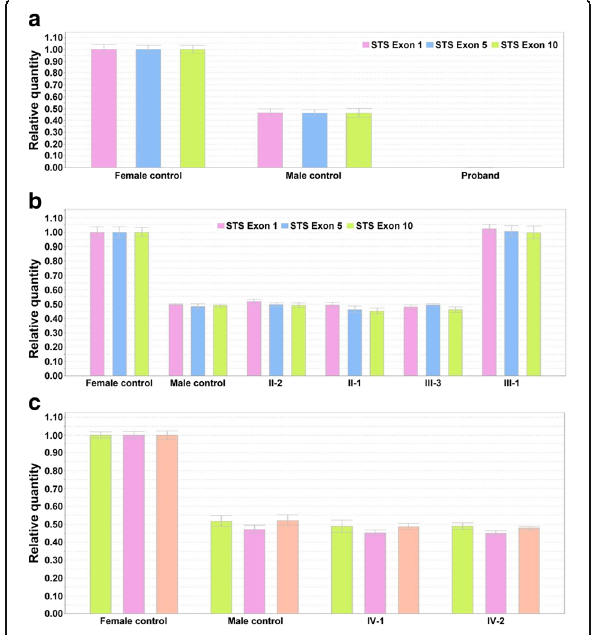
Fig. 3 Expression of STS gene in a Chinese family with ichthyosis.